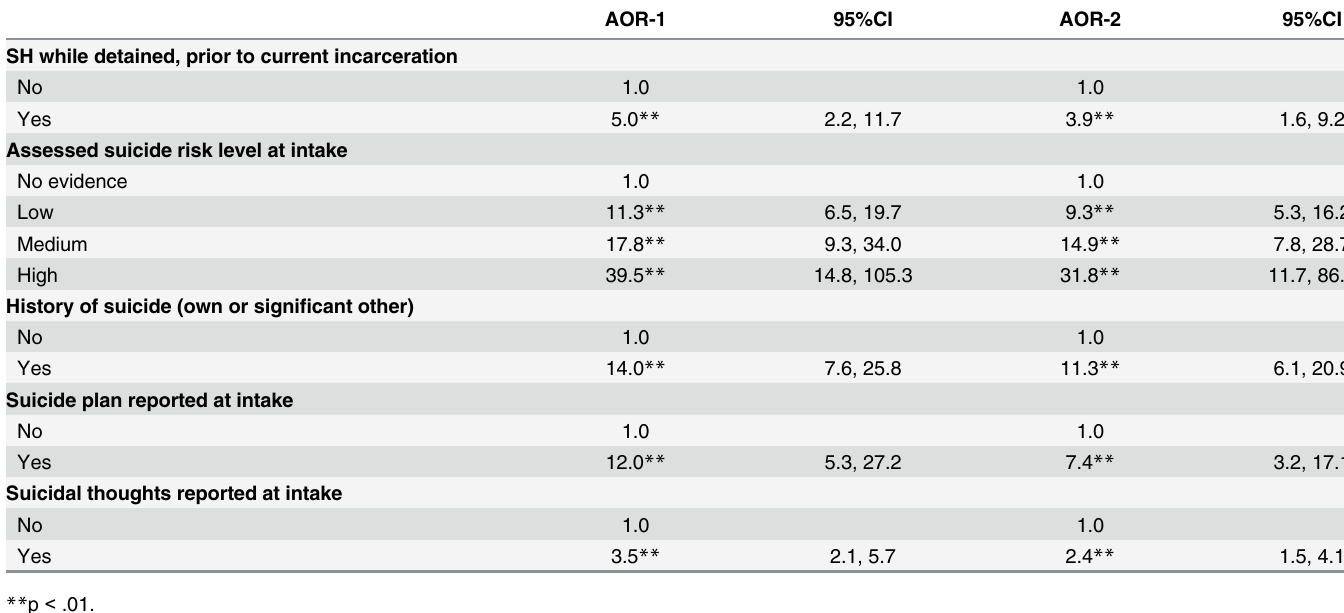
Table 3. Suicide-related correlates of self-harm during most recent incarceration.